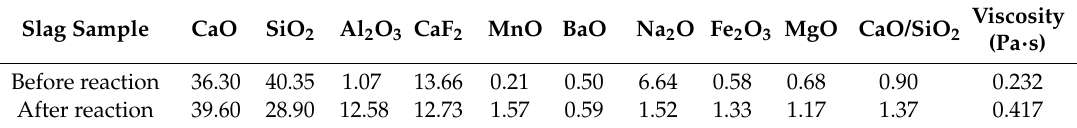
Table 3. Compositions of industrial slag before and after steel/slag interfacial reaction (wt.%). Slag Sample